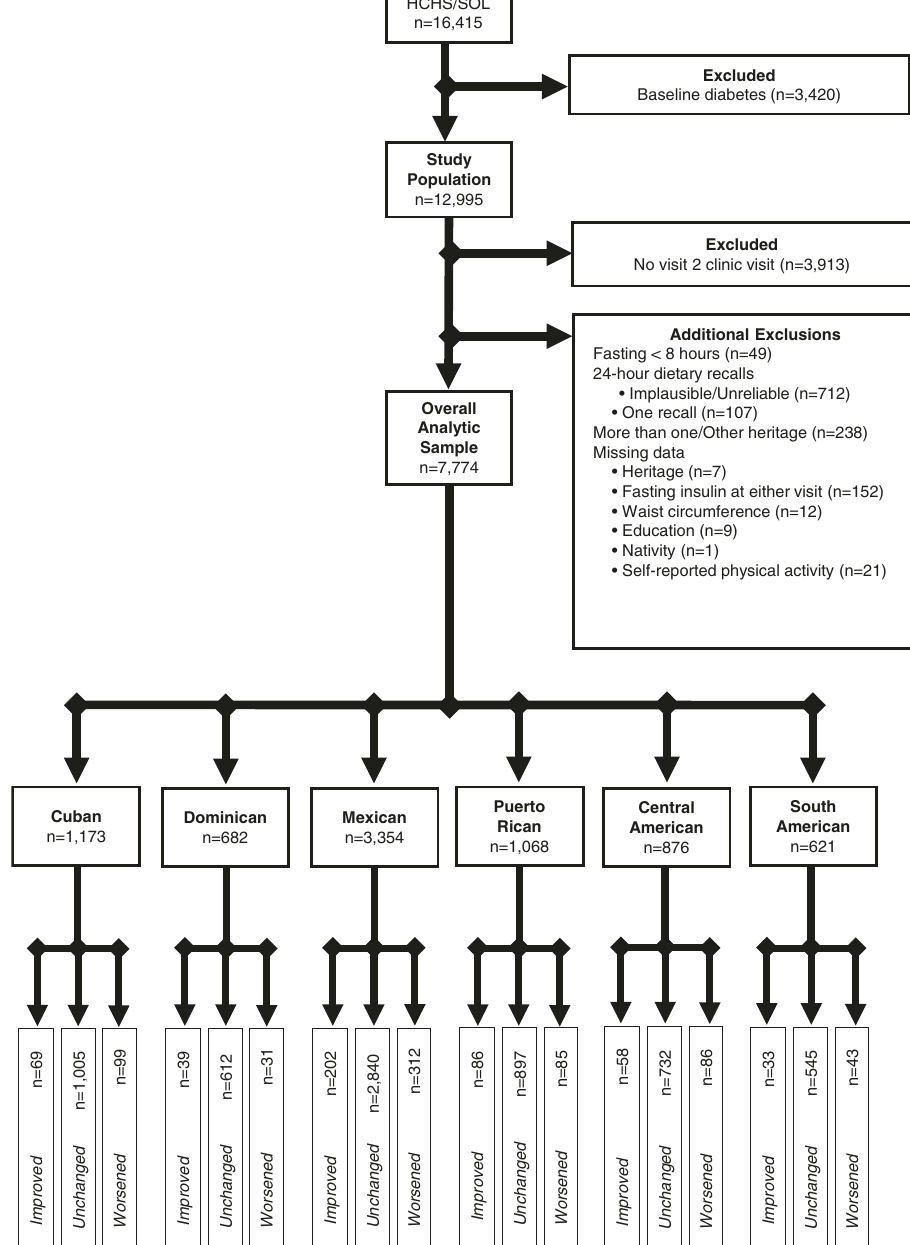
Fig. 1 Flowchart of heritage-speci fi c analytic samples by insulin resistance status at 6 years in HCHS/SOL a . a Hispanic Community Health Survey/Study of Latinos,